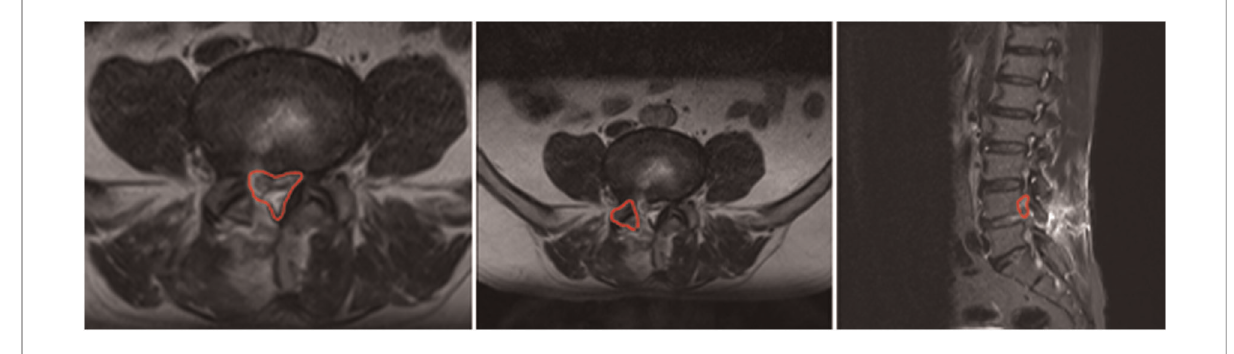
FIGURE 1 Method of the measurement of CSA-SC, CSA-IVF, and